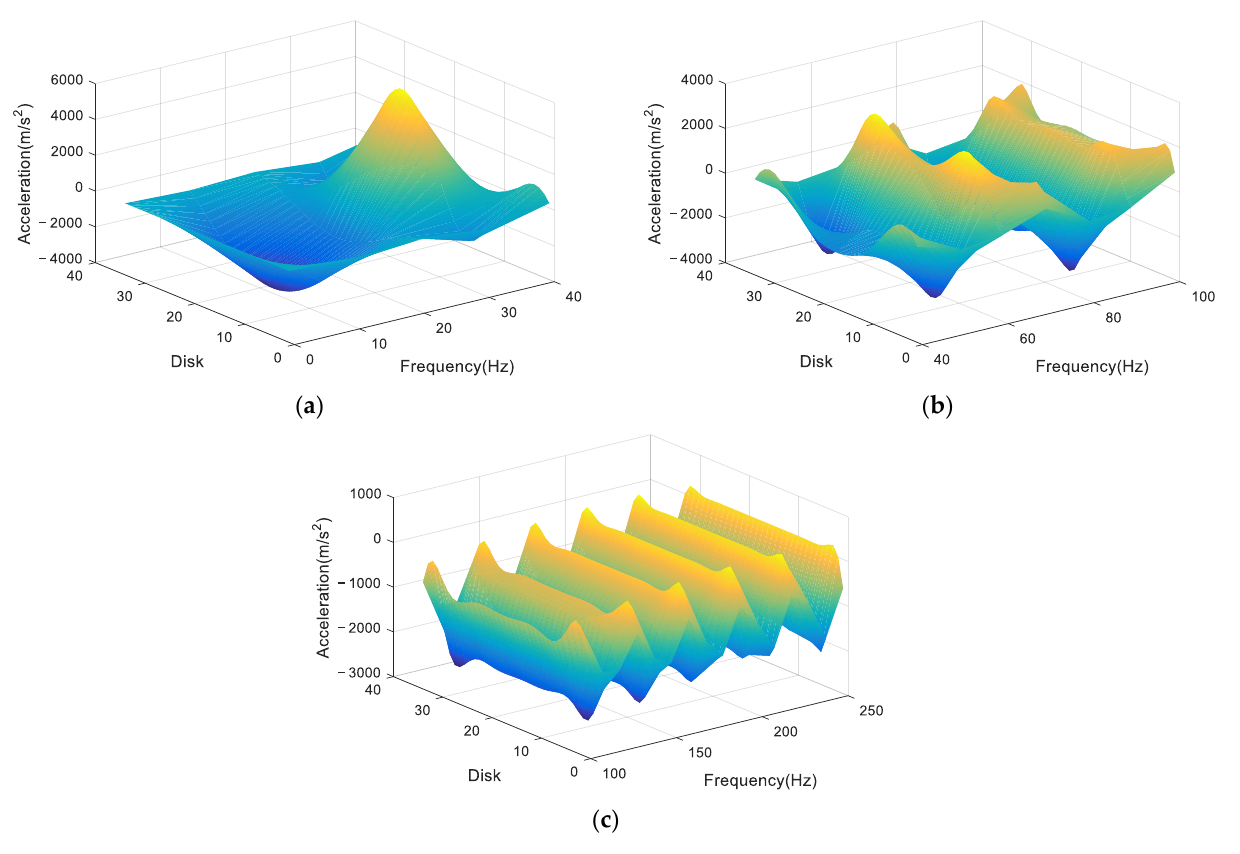
Figure 7. Displacement response of the top disk.